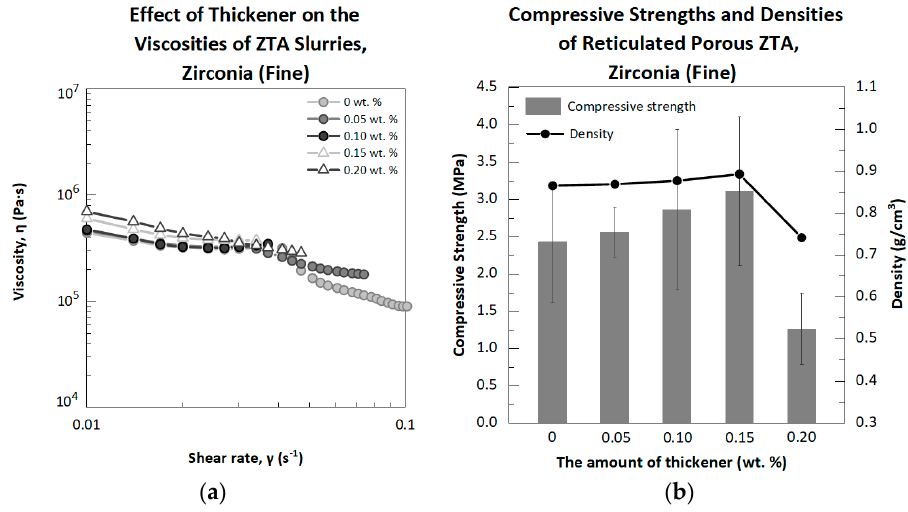
Figure 10. ( a ) Viscosities as a function of the shear rate of ZTA slurries with different amounts of thickener, and ( b ) compressive strength and density outcomes according to the amount of thickener used.